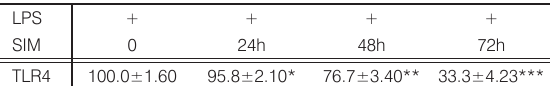
Table 3. The influence of simvastatin on the TLR4 protein expression in different time.